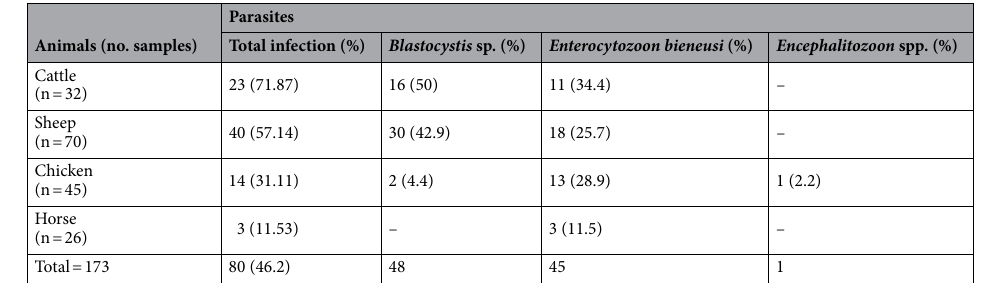
Table 1. Intestinal parasites identified in domestic animals by real-time PCR.